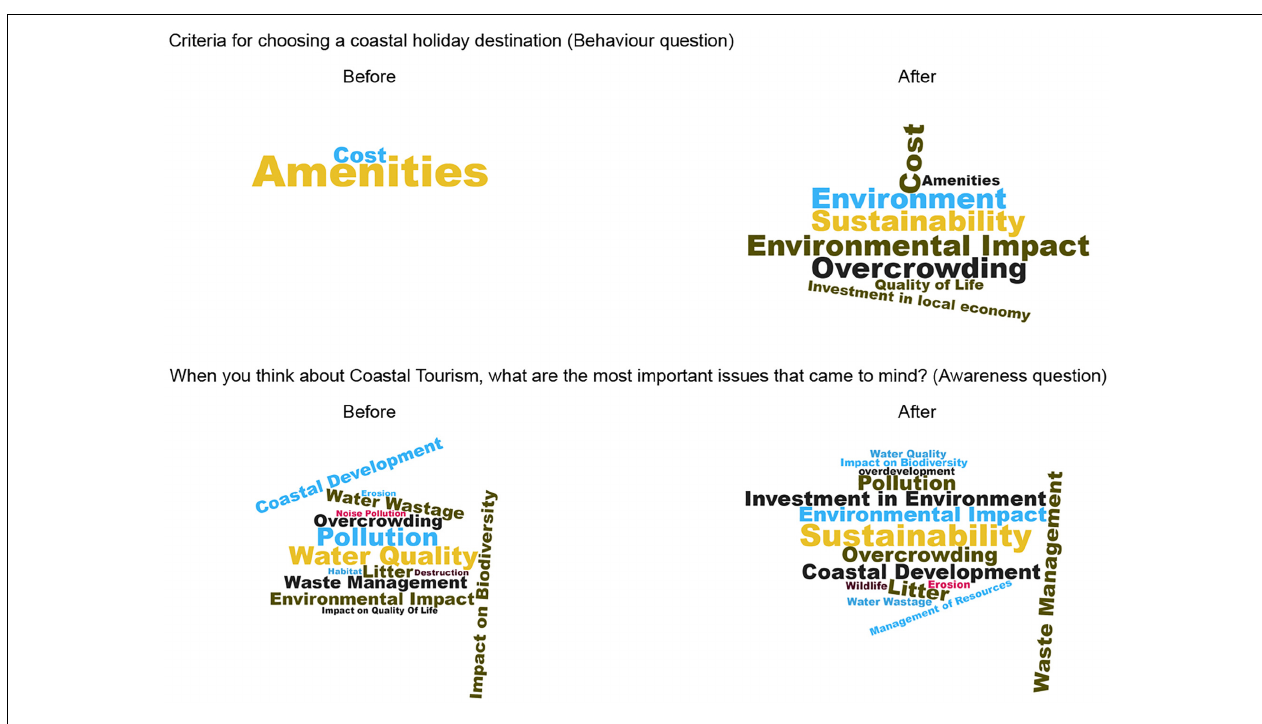
FIGURE 7 | Wordclouds representing before and after survey responses for two qualitative